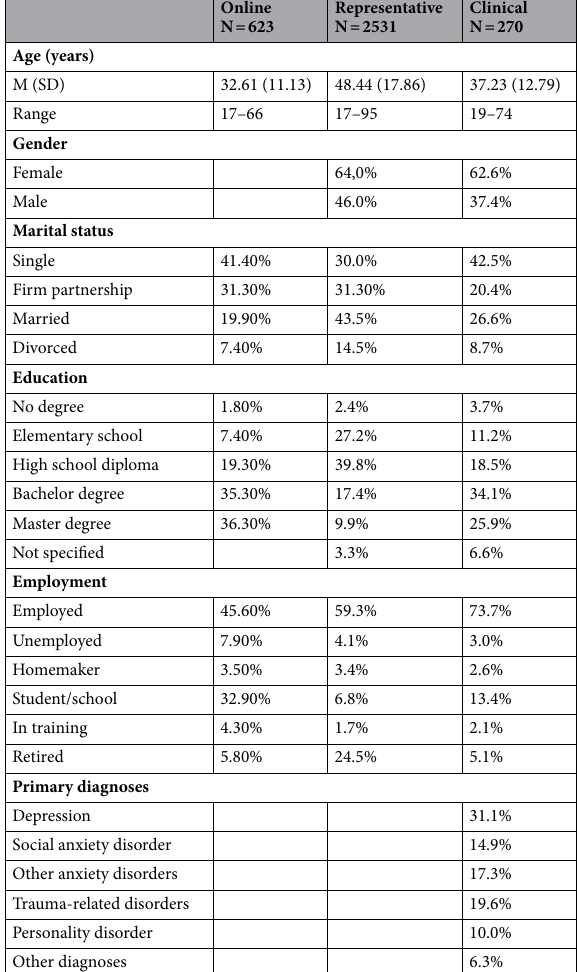
Table 4. Sociodemographic characteristics of the three